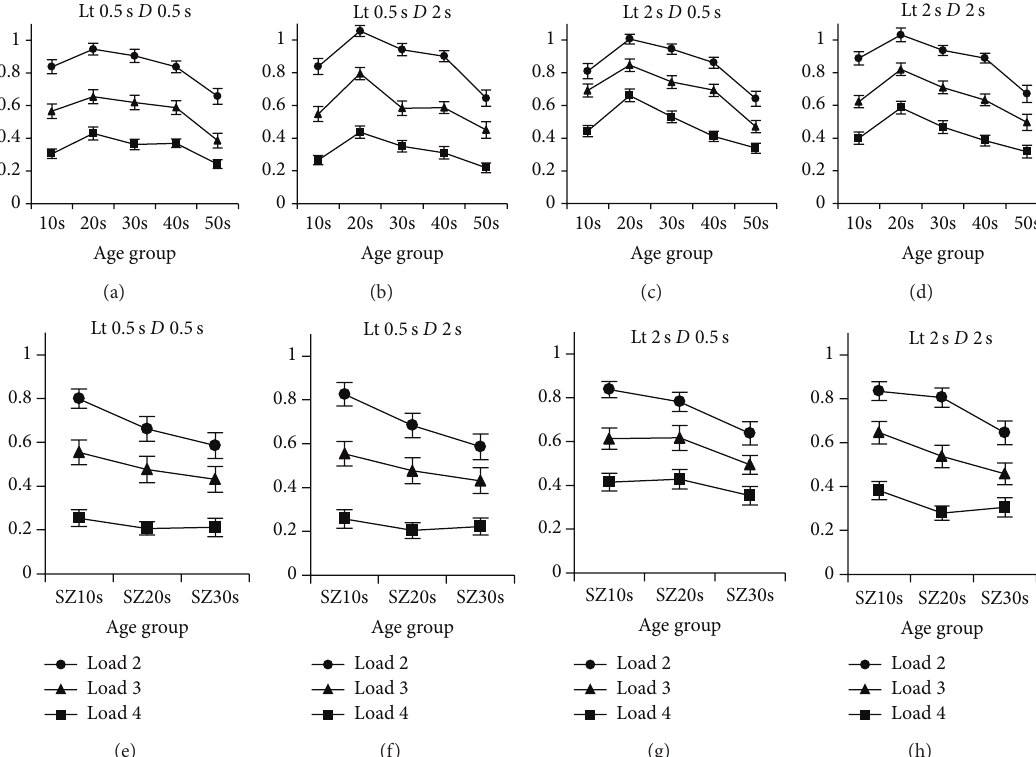
Figure 2: Comparison of schizophrenic and healthy groups. SWAPS showed the highest score in the age 20–27 healthy control group (group 20s) but not in schizophrenia patients ages 20–29 (group SZ20s). (a–d) show the accuracy per second in 5 healthy control age groups (10s, 20s, 30s, 40s, and 50s), at different difficulty loads and with different combinations of learning time and delay span. (e–h) show the accuracy per second for 3 age groups in schizophrenia patients (SZ10s, SZ20s, SZ30s), under the same learning time and delay span conditions as the healthy control groups. Lt: learning time (0.5 seconds or 2 seconds); 𝐷 : delay span (0.5 seconds or 2